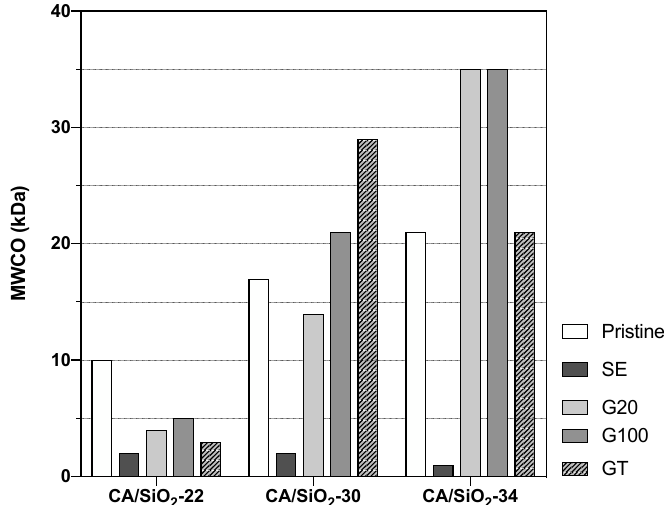
Figure 5. Membranes’ molecular weight cut-off, MWCO .